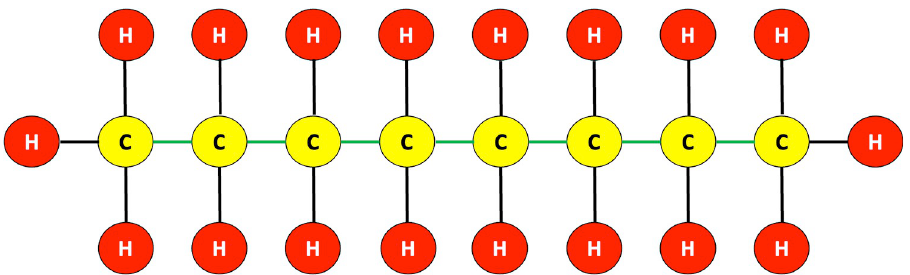
Fig 3. Chemical bonds of an octane compound C 8 H 18 having more than one junction nodes.